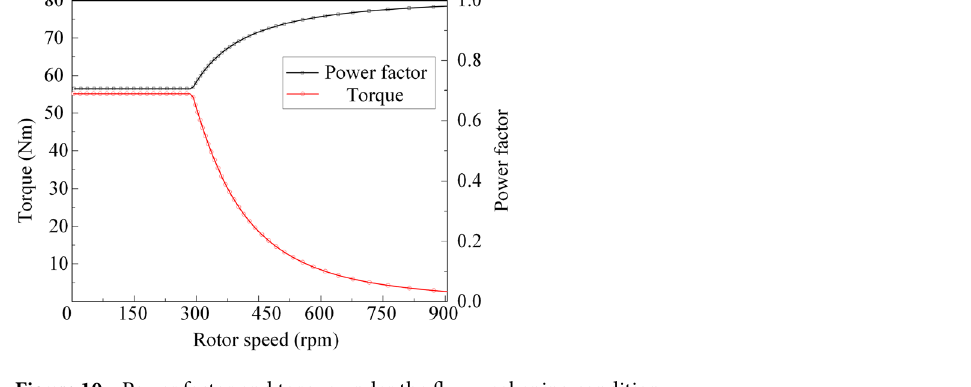
Figure 10. Power factor and torque under the flux-weakening